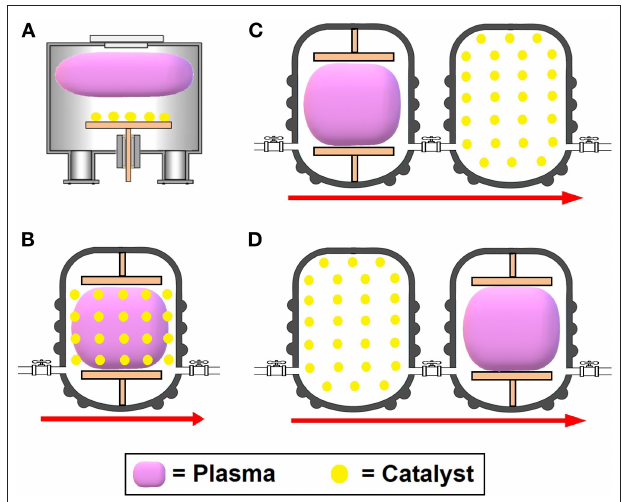
FIGURE 2 | Illustrative examples of (A) catalyst preparation or treatment using non-thermal plasma, (B) a one-stage hybrid system, (C) a two-stage hybrid system with a downstream plasma reactor, and (D) a two-stage hybrid system with an upstream plasma